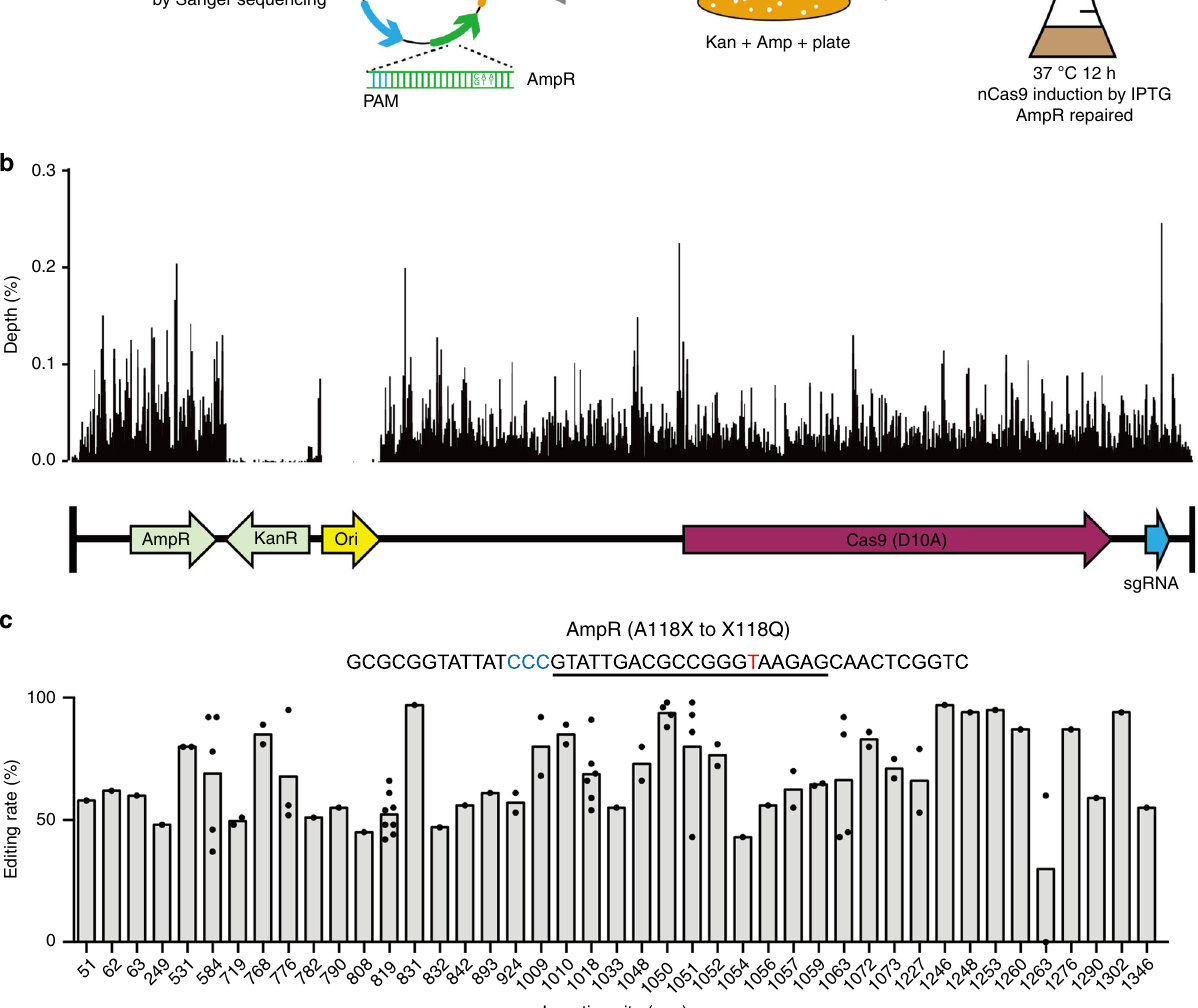
Fig. 1 Genetic screens for tolerant sites on nCas9 using transposon-mediated random mutagenesis. a Work fl ow. AmpR (A118X), ampicillin resistance gene bearing a premature stop codon. b Insertion site distribution pattern across the entire plasmid in the unscreened library, revealed by deep-seq. c nCas9 insertion sites in the screened library and the corresponding A > G conversion rates at the Amp resistance gene in the same plasmid, as revealed by Sanger sequencing. Each dot represents a single Amp-resistant colony, with a total of 84 colonies examined from three independent experiments. The AmpR sequence surrounding A118X is shown, with the targeted base and PAM highlighted in red and blue, respectively. A:T to G:C editing at the target would convert the stop codon to CAA (encoding